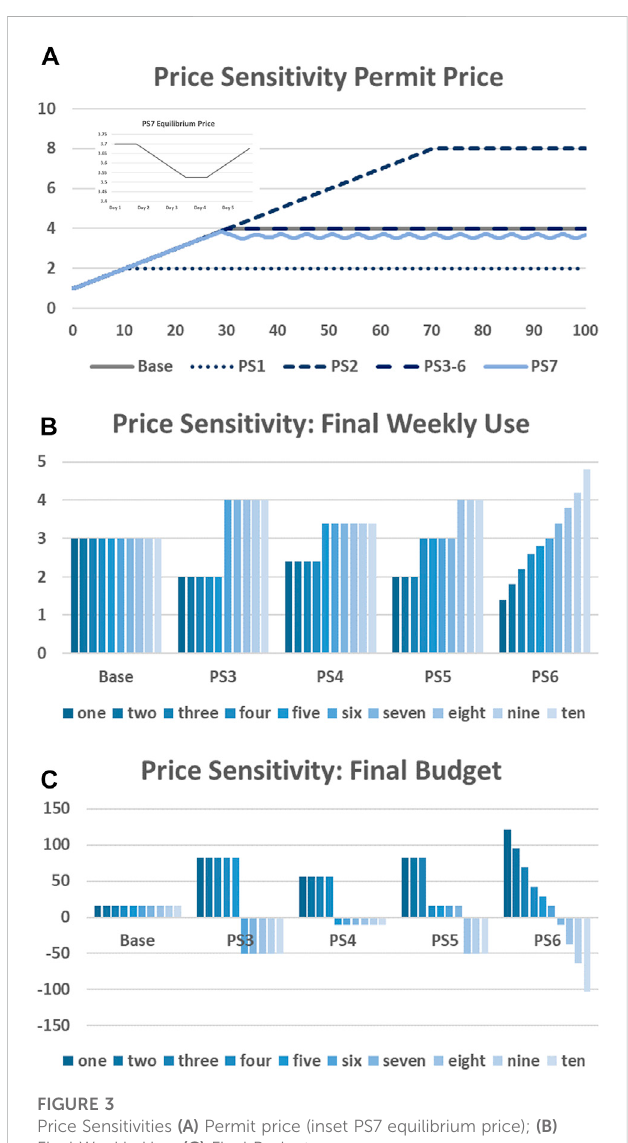
FIGURE 3 Price Sensitivities (A) Permit price (inset PS7 equilibrium price); (B) Final Weekly Use; (C) Final